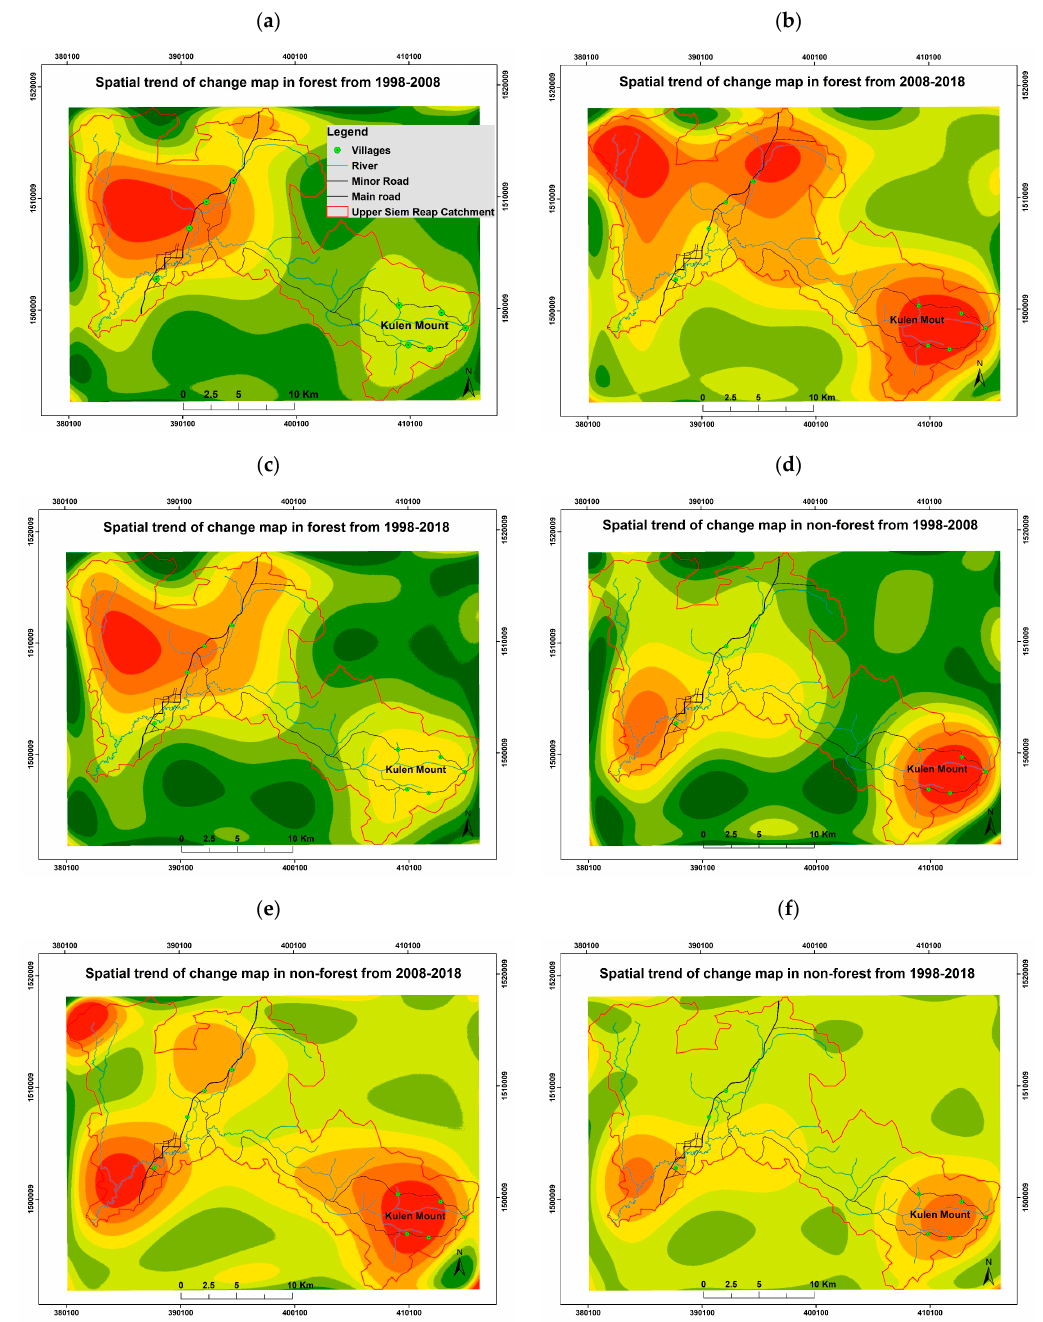
Figure 8. The spatial trend of change in forest ( a – c ) and non-forest ( d – f ) cover during 1998–2018 (red to dark green colour represents high to low level of trend change).